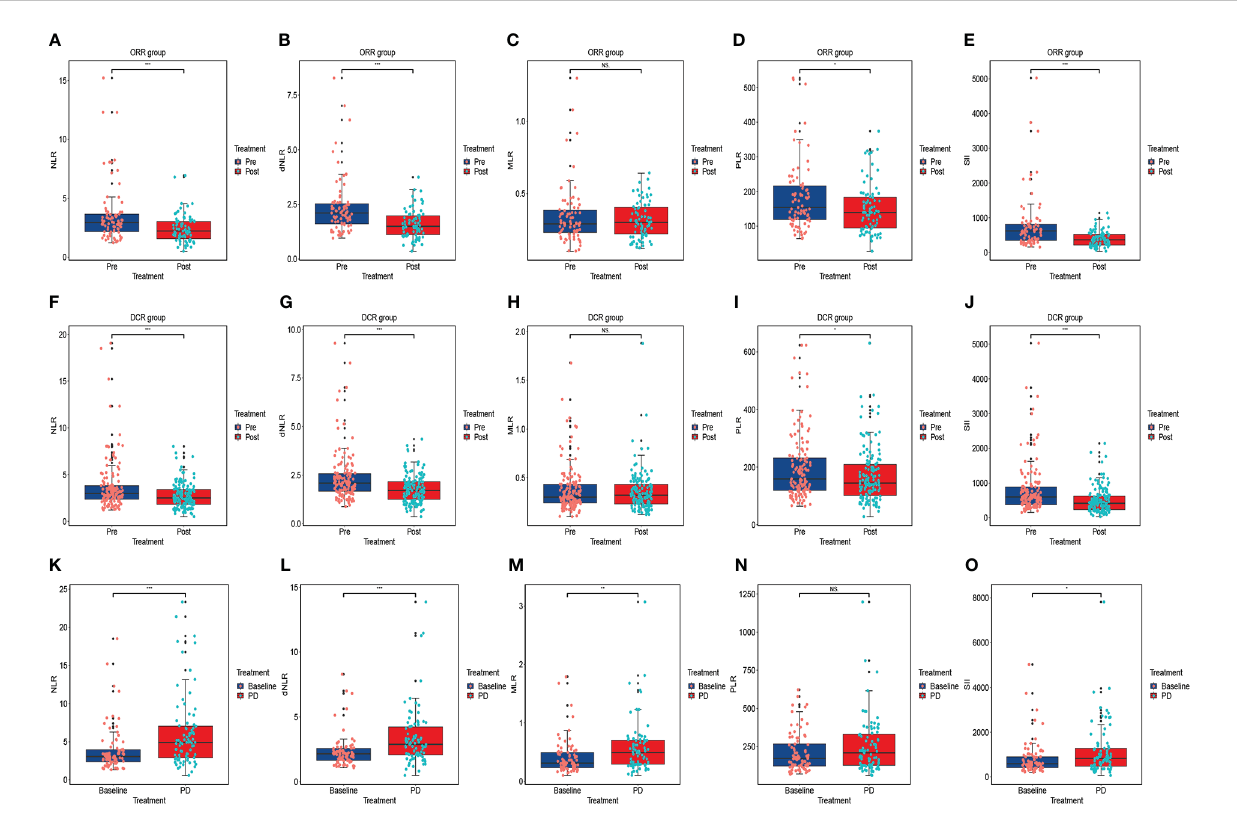
FIGURE 4 The changes in in fl ammatory markers in advanced or metastatic ESCC patients according to the ef fi cacy of anti-PD-1 treatment including ORR group (A – E) , DCR group (F – J) ; The changes in in fl ammatory markers when the failure of anti-PD-1 treatment compared to baseline (K – O) . ORR: the patient who obtained PR, or CR were included in this group; DCR: the patient who achieved SD, PR or CR were included in this group. NS, No statistic signi fi cance; *P < 0.05; **P < 0.01; ***P <